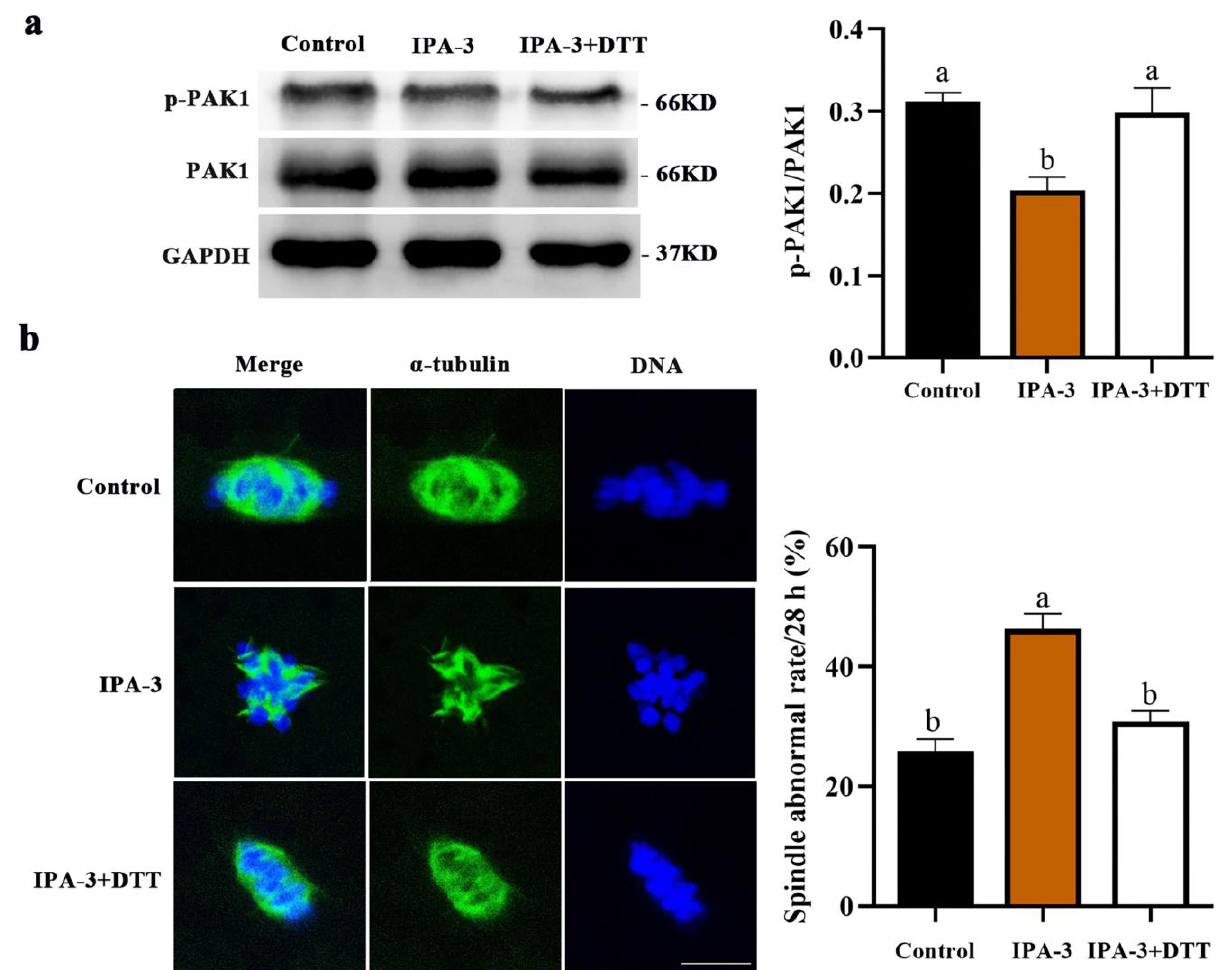
Figure 5. Effect of DTT on spindle assembly during the first meiotic division in IPA-3-treated oocytes. ( a ) Effect of DTT on the expression of p-PAK1 in the IPA-3-treated oocytes after 28 h of culture in vitro. ( b ) Effect of DTT on the spindle morphology and chromosome alignment in the IPA-3-treated oocytes ( n = 108 for the control group; n = 110 for 30 µM IPA-3 group; n = 107 for the IPA-3 + 1 mM DTT group). Green, α-tubulin. Blue, chromosome. Scale bars are 10 μm. a, b Values with different superscript letters above columns indicate significant differences ( p < 0.05).